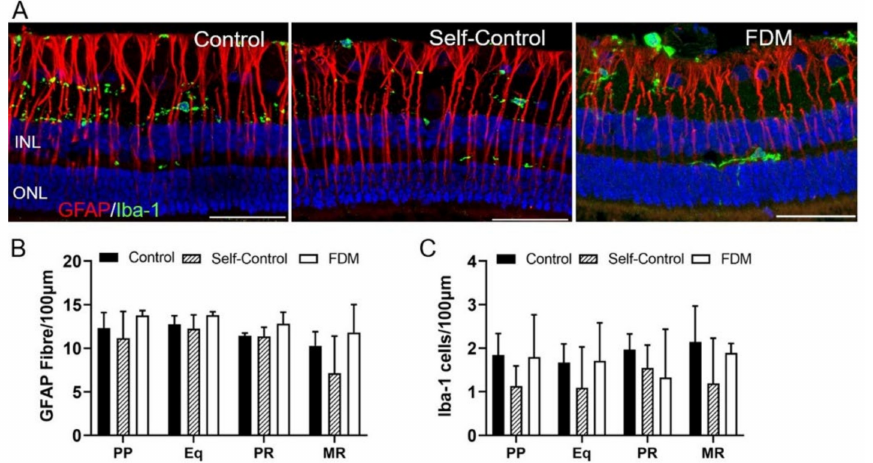
Figure 7. Retinal Müller glia and microglial cells. ( A ) Representative confocal images taken from the posterior pole (PP) of the retina stained for GFAP (red) and IBA-1 (green) in naïve control, self-control and FDM eyes. Blue—DAPI staining. ( B , C ) Quantitative data showing the number of GFAP + Müller cells ( B ) and IBA-1 + microglial cells ( C ) in different retinal locations of the three groups. Scale Bar: 50 µ m. Mean ± SD, n =